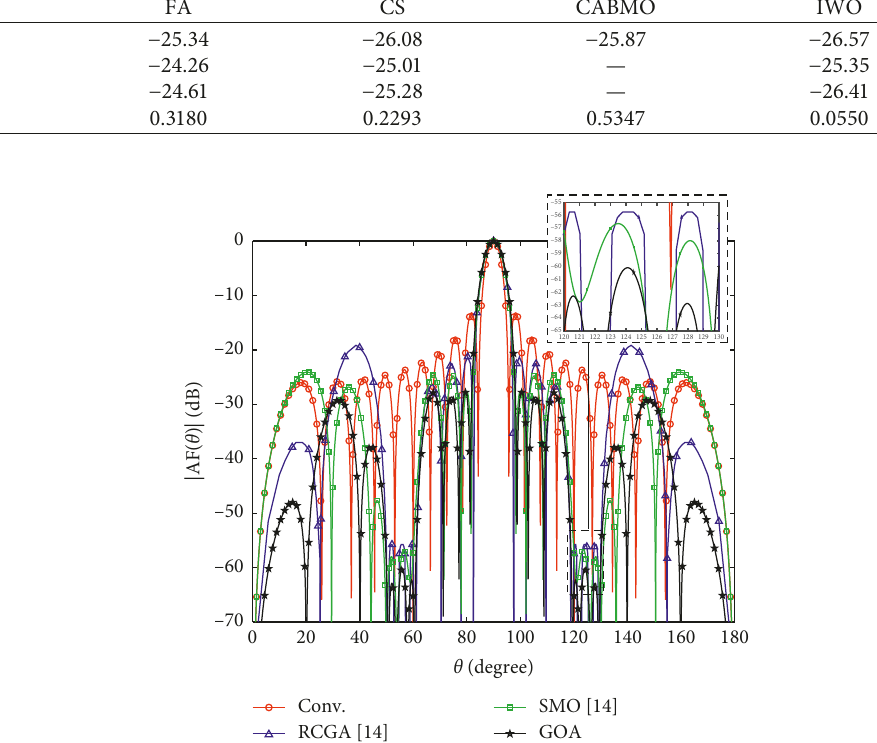
Figure 13: Array factor of 20-element linear array for example